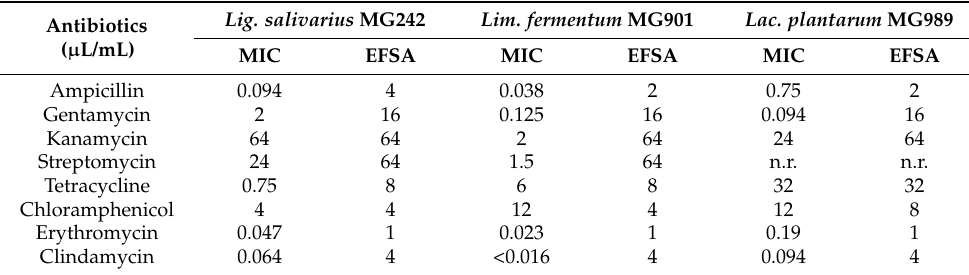
Table 2. Minimum inhibitory concentration test results for the